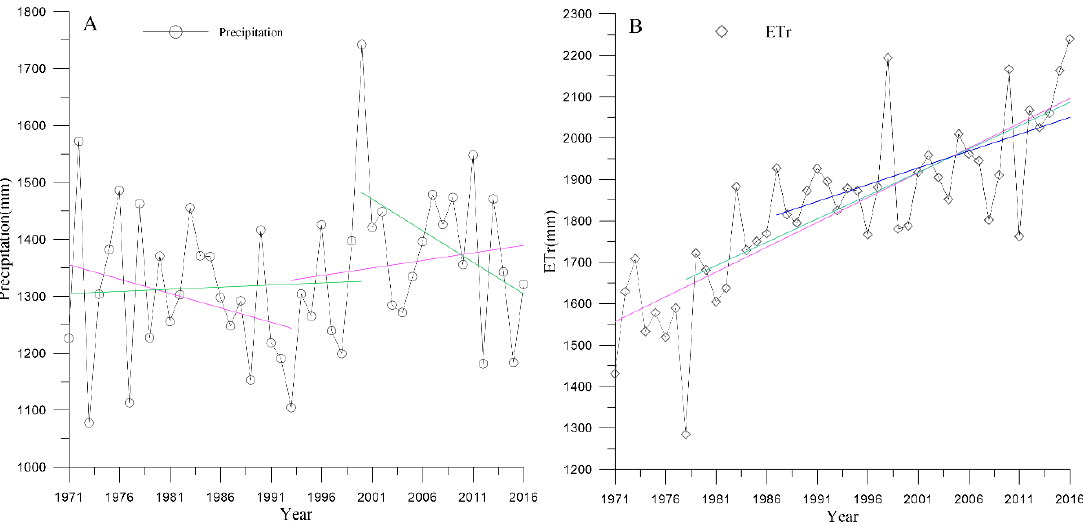
Figure 8. Temporal variation in precipitation ( A ) and ETr ( B ) during the period of 1971–2016 over the Mun River Basin, Thailand. The colorful lines present trends of precipitation and ETr during different time periods. Table 2. Mean and trends of ETr across different time periods over the Mun River Basin.